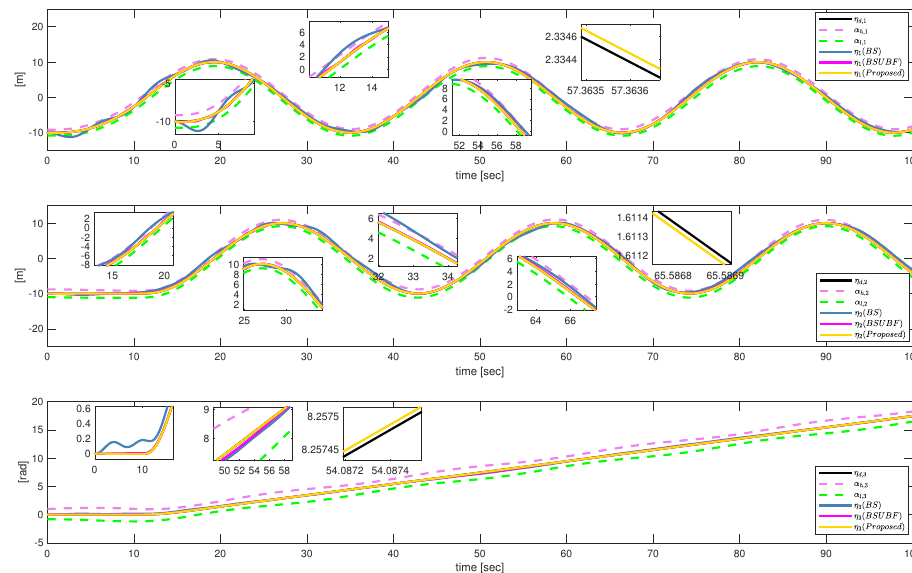
Figure 5. Time responses of ψ under step-type disturbance.